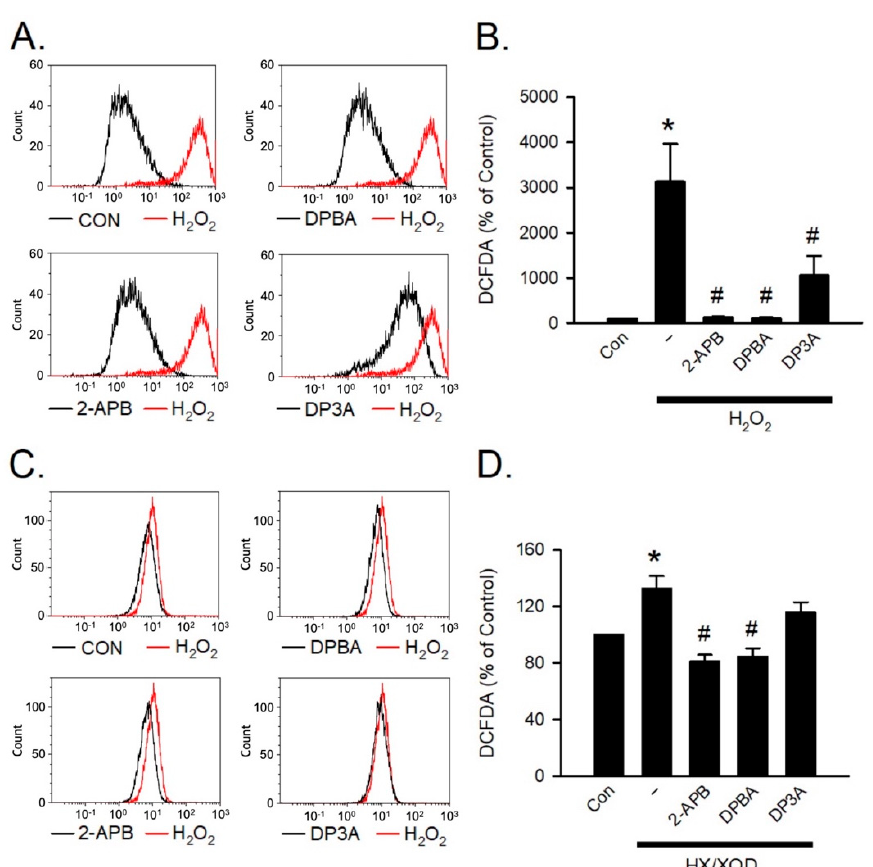
Figure 4. Scavenging effect of 2 ‐ APB analogues on intracellular H 2 O 2 elevation. Flow cytometric analyses show scavenging effect of 2 ‐ APB analogues on intracellular H 2 O 2 elevation determined by activity of the fluorescent probe, 2’, 7’ ‐ dichlorodihydrofluorescein diacetate, acetyl ester (CM